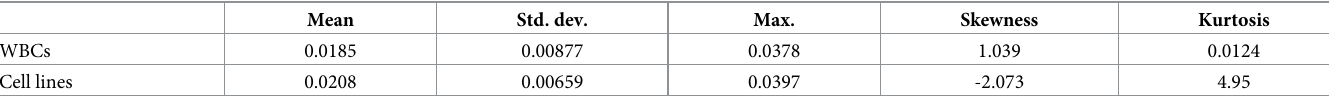
Table 1. Ensemble mean values of statistical parameters of OPL/PL over all WBCs and CLs.